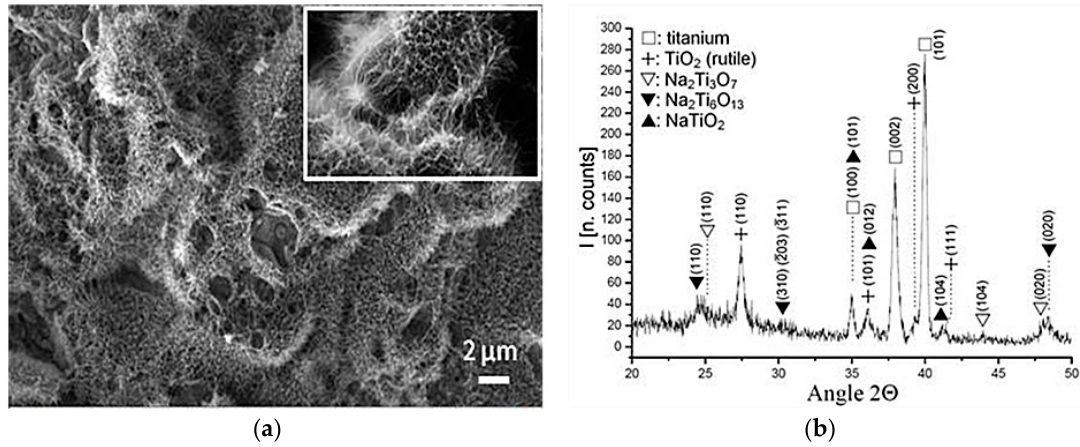
Figure 2. ( a ) SEM micrograph showing a microporous layer of sodium titanate on NiTi surface (alloy A); and ( b ) GI-XRD pattern of sodium titanate layer.